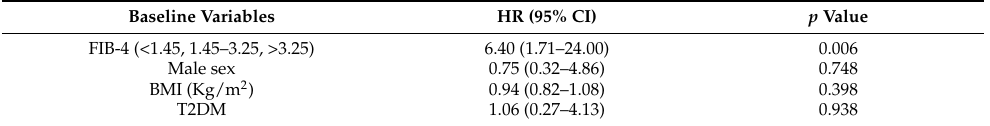
Table 3. Multivariate adjusted Cox regression analysis for baseline factors associated with HCC development. Hazard ratios and 95% CIs of outcome by risk score Table 2. Cumulative probability and hazard ratios of HCC according to FIB-4 risk category.